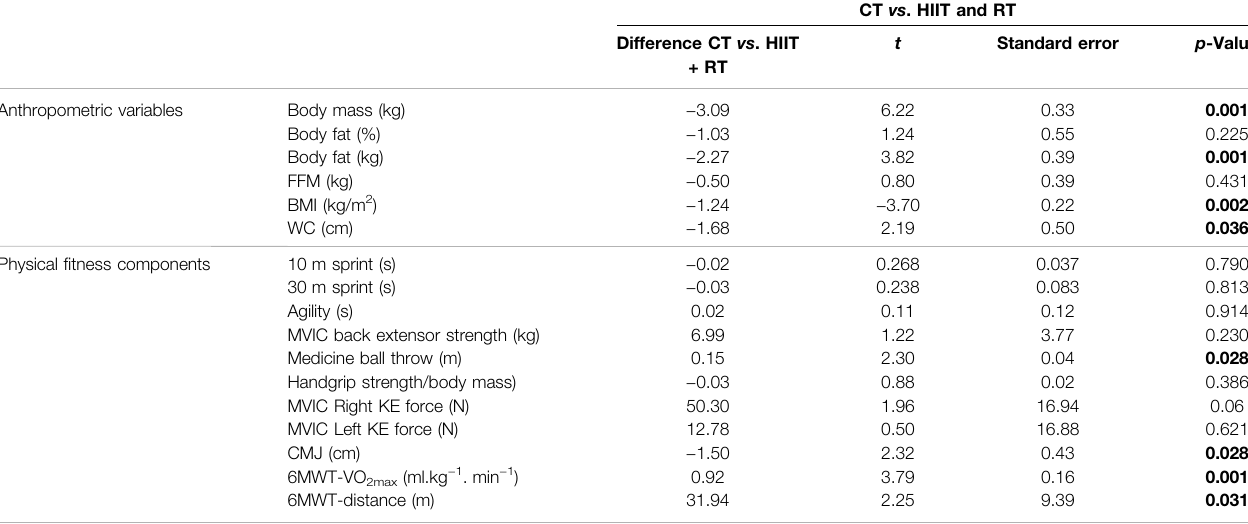
FFM, Fat-free mass; BMI, body mass index; WC, waist circumference; MVIC, maximal voluntary isometric contraction; KE, knee extensors; CMJ, countermovement jump; 6MWT, six minuteswalking test; VO 2max , maximal O 2 uptake. The bold values are mean that Interaction Anovap-Value and Contrast p-Value are signi fi cant; given that the alpha level of signi fi cance was set at p ≤